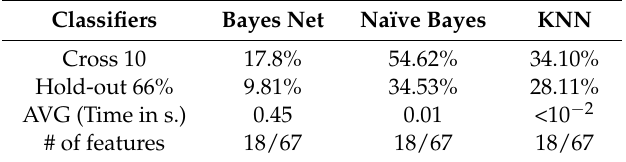
Table 10. Results using geometrical features for IAM Online Handwriting DB.